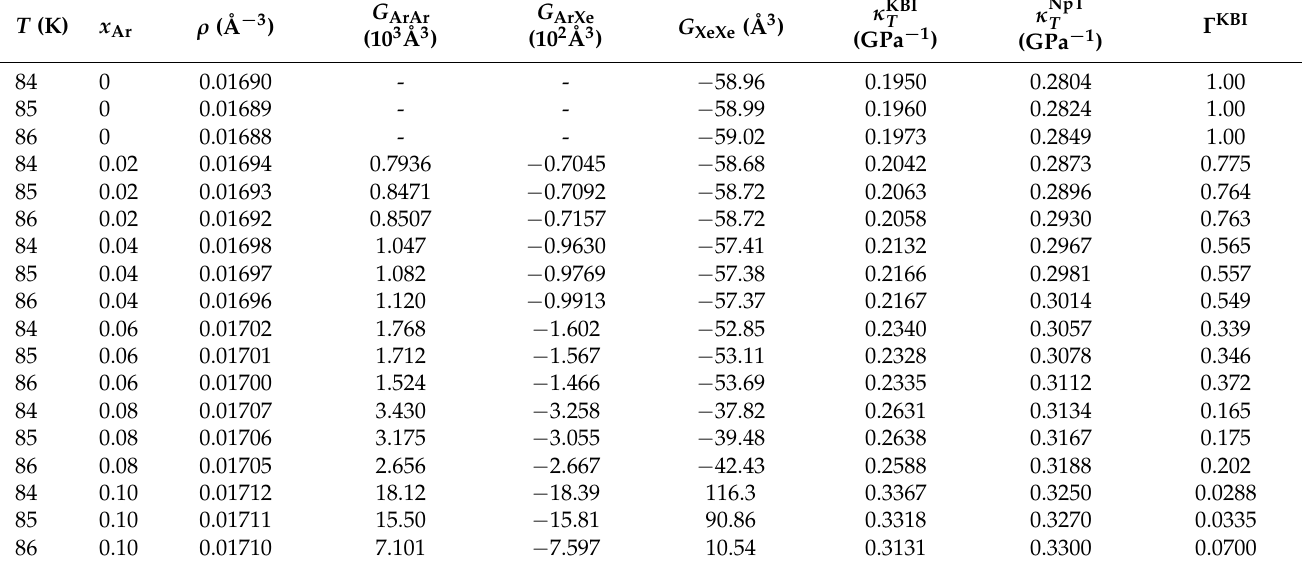
from NpT simulations as a T